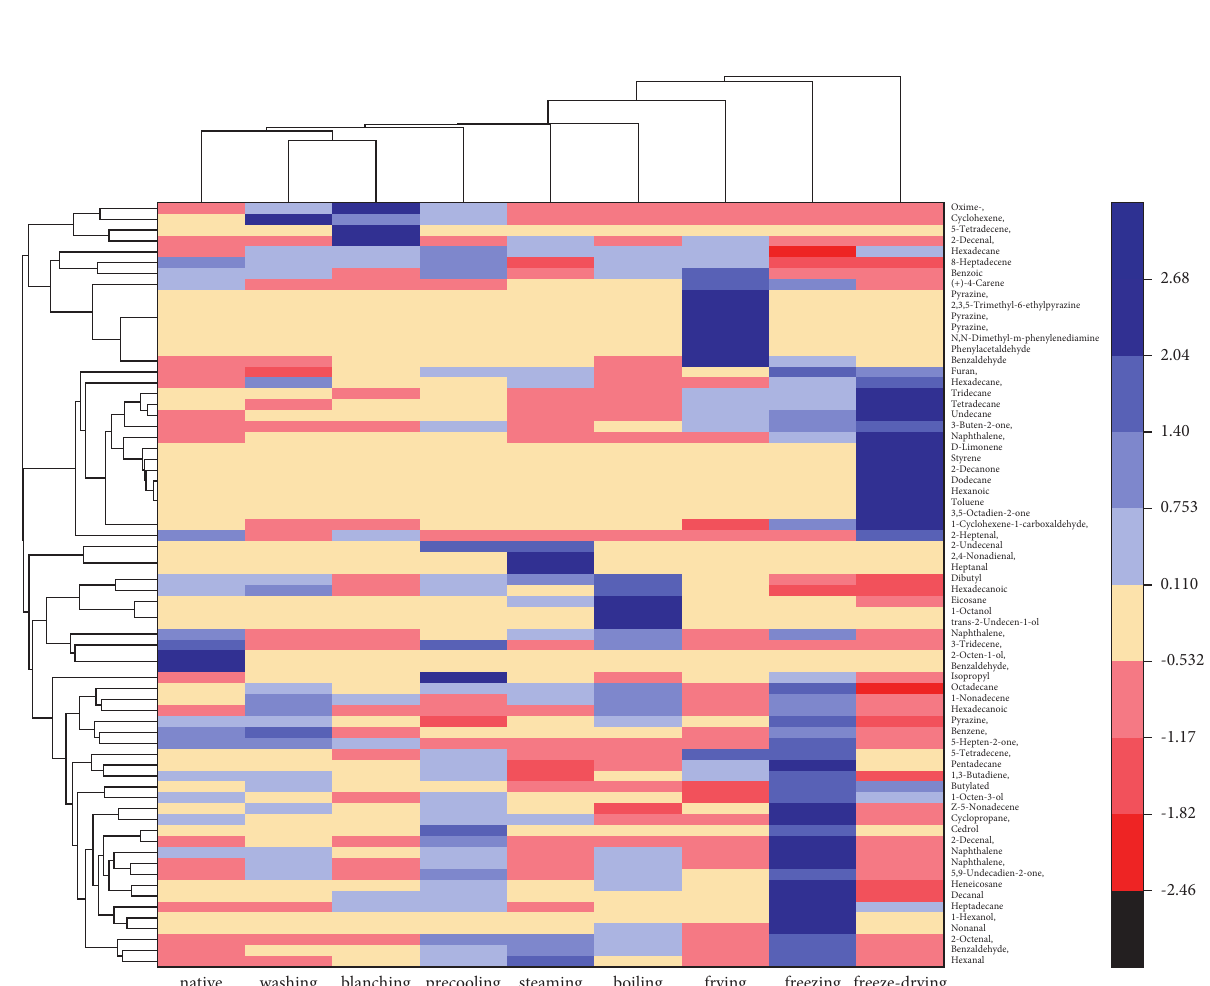
Figure 3: Heat map and cluster analysis of peas under nine kinds of different